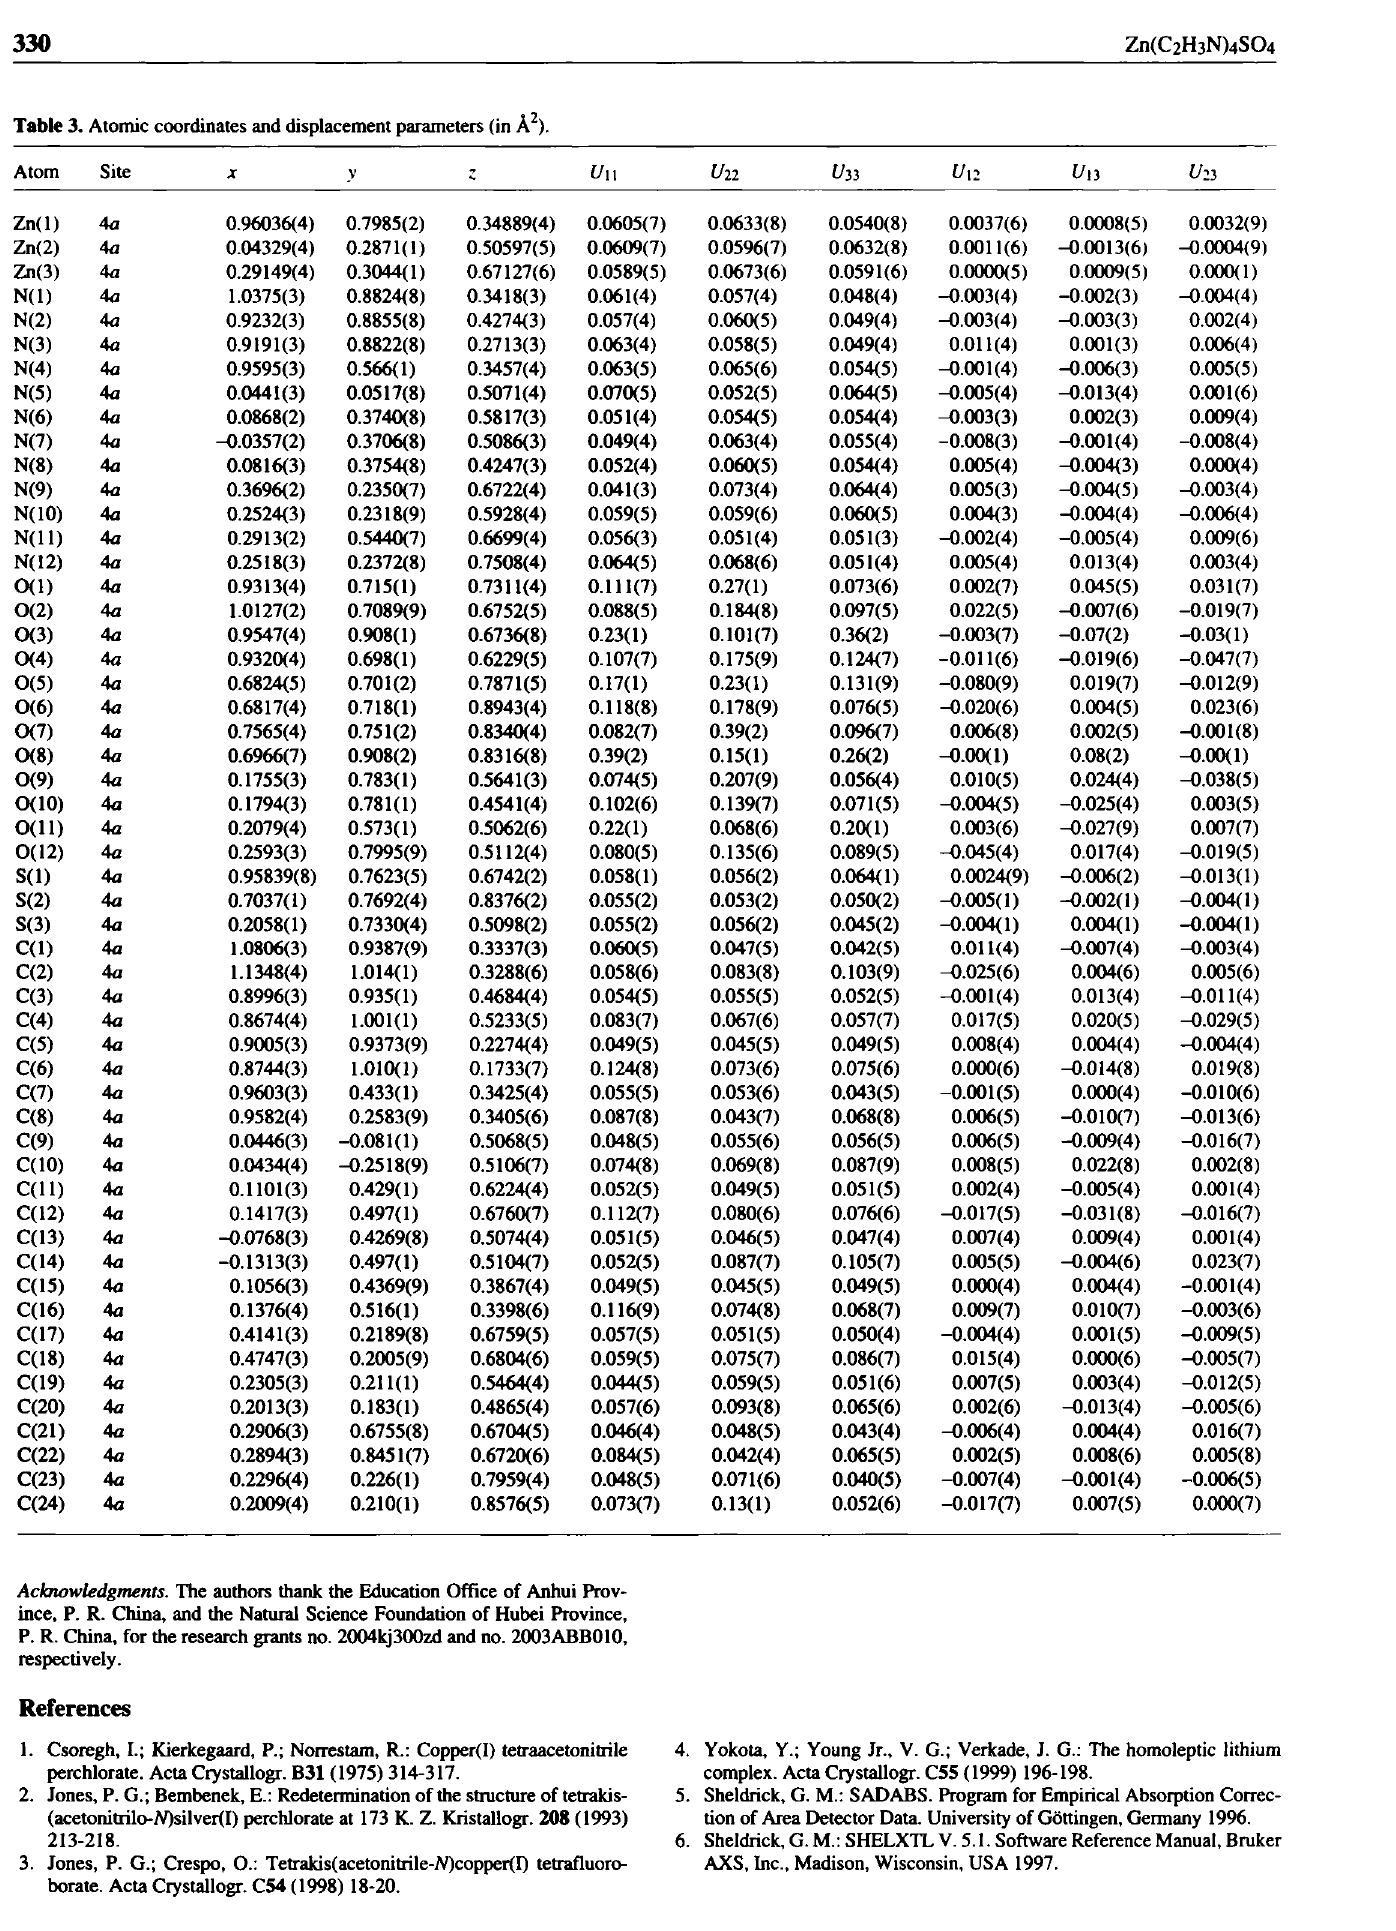
Table 3. Atomic coordinates and displacement parameters (in Â 2